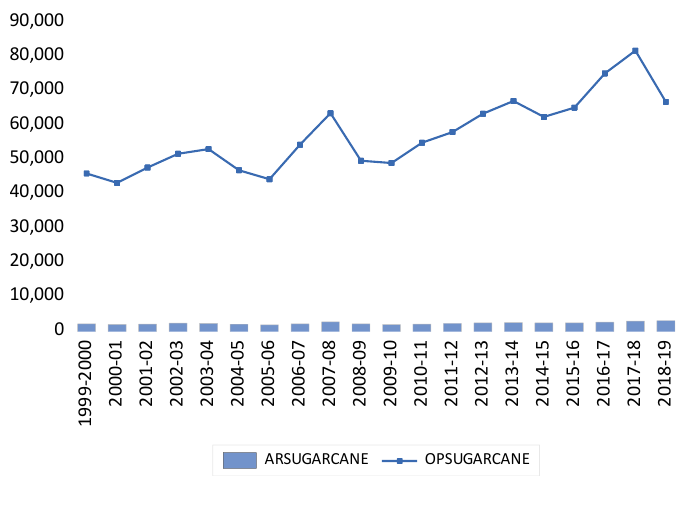
Figure 3: Area and Yield of Sugarcane crops, 1999 –